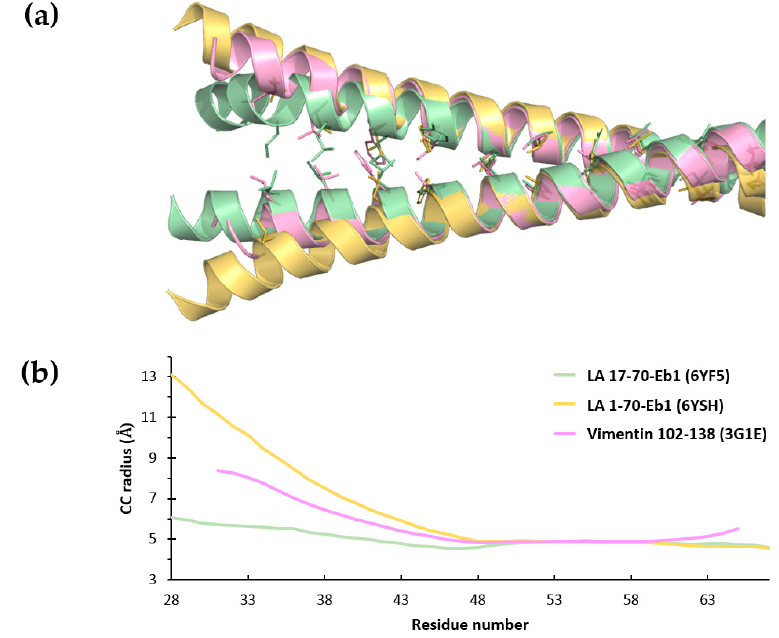
Figure 5. Analysis of the coil1A dimer opening in various structures (PDB codes are shown in brackets). ( a ) Superposition of the coil1A segments seen in LA 17-70-Eb1 (green), LA 1-70-Eb1 (gold) and vimentin 102-138 fragment with mutation Y117L (pink; PDB code 3G1E [30]). The residues in ‘a’ and ‘d’ positions forming the hydrophobic core are shown as sticks. ( b ) CC radius plotted as a function of residue number (according to the LA sequence) for the coil1A regions in the three structures, as determined using TWISTER [58].